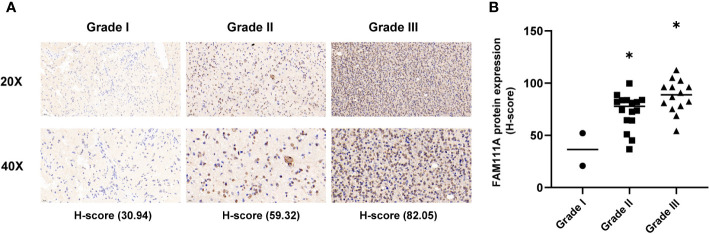
The protein expression of FAM111A in lower-grade glioma (IHC). (A) upper, × 20; lower, × 40. (B) The staining of FAM111A was scored based on the H-score system. FAM111A protein expression was higher in high-grade lower-grade glioma (LGG). *P < 0.05, **P< 0.01, ***P < 0.001.